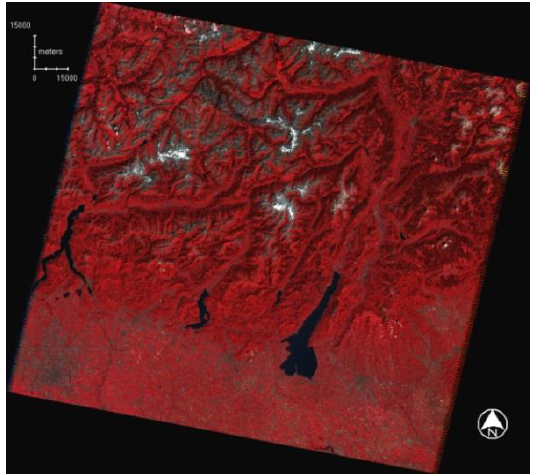
Figure 2. Landsat frame of the study area (false-colour IR).